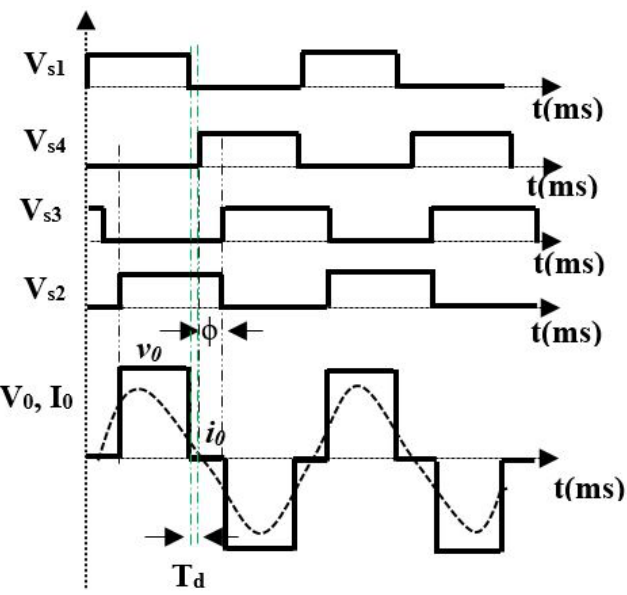
Figure 17. PS pulse